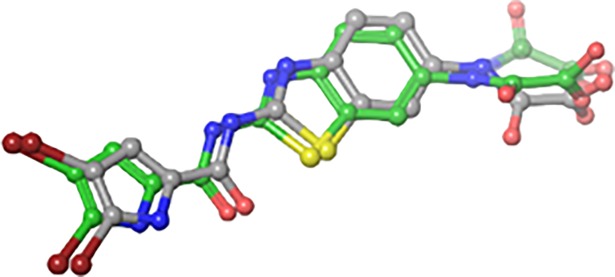
Native ligand (grey) overlap with its best docked pose (green) in a re-docking protocol.